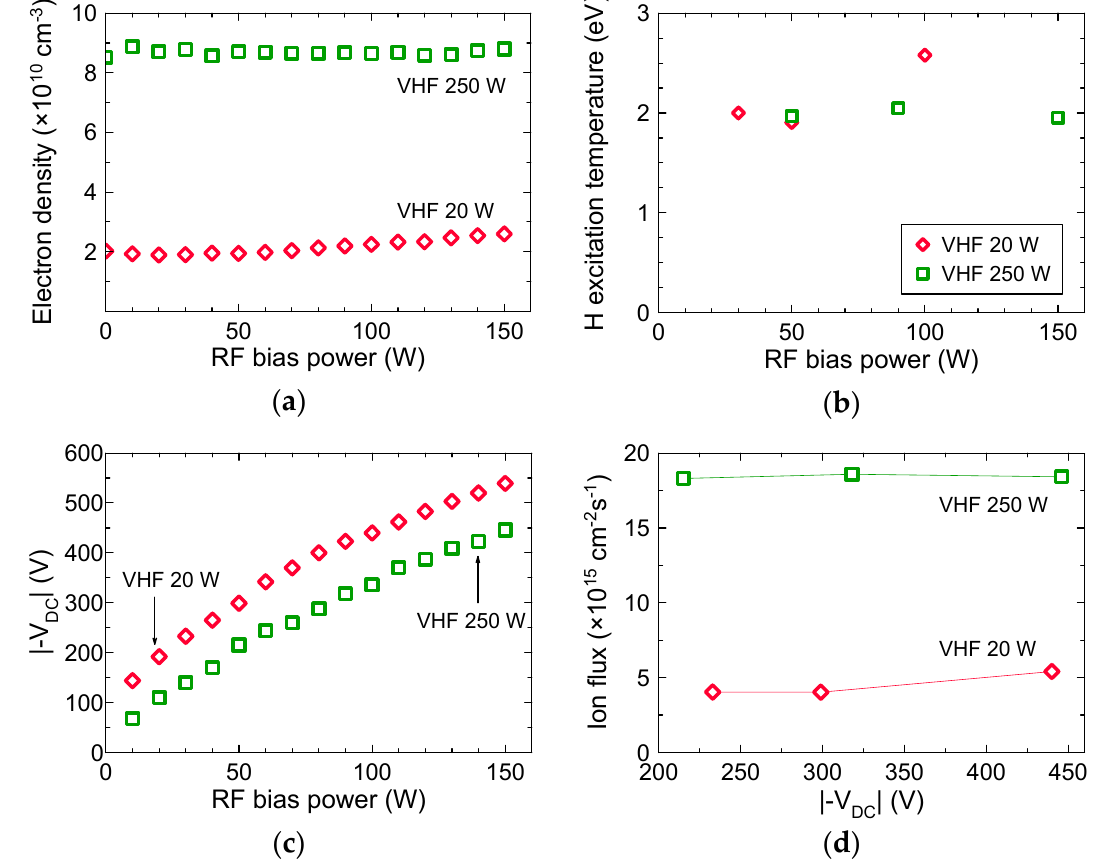
Figure 2. ( a ) Electron densities, ( b ) H excitation temperatures, and ( c ) magnitudes of negative self-bias voltages (|- V DC |) as a function of RF bias power, and ( d ) ion fluxes as a function of |- V DC |. Diamonds ( ◇ ) and squares ( □ ) correspond to 20 and 250 W in very high frequency (VHF) power, respectively.